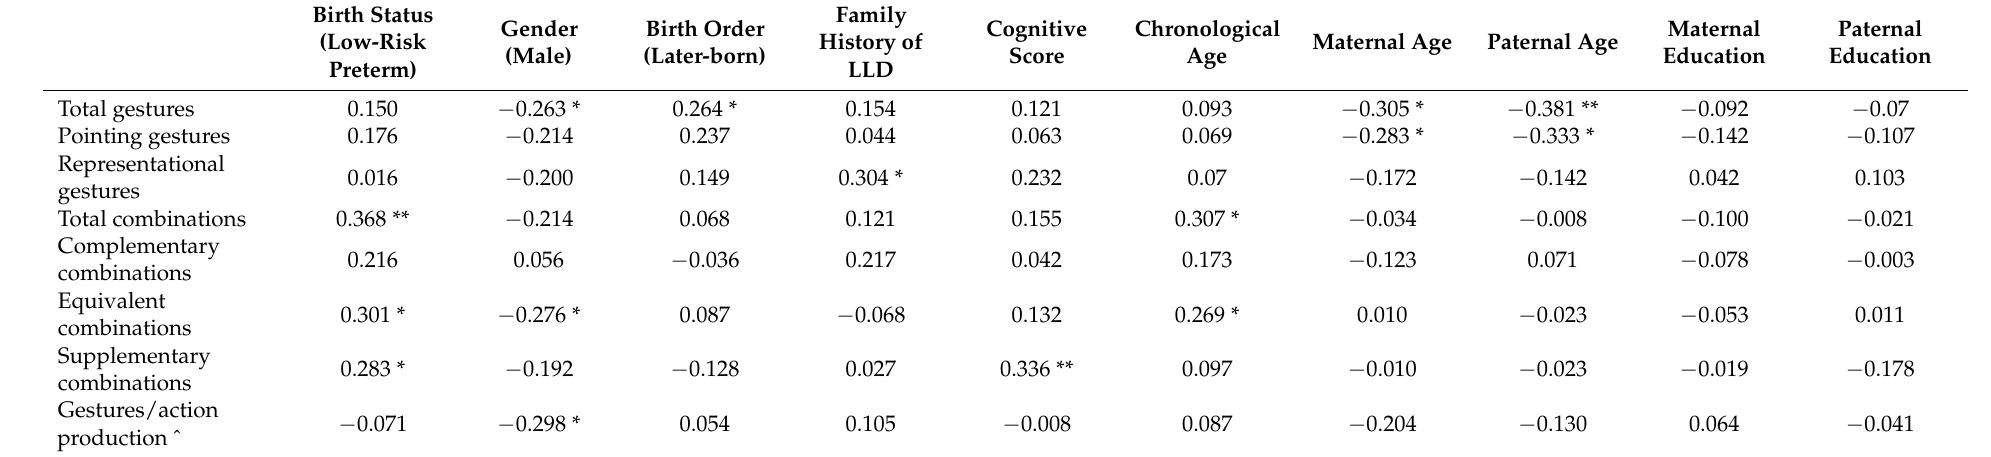
Table A2. Correlations between children’s gestural measures and individual and environmental